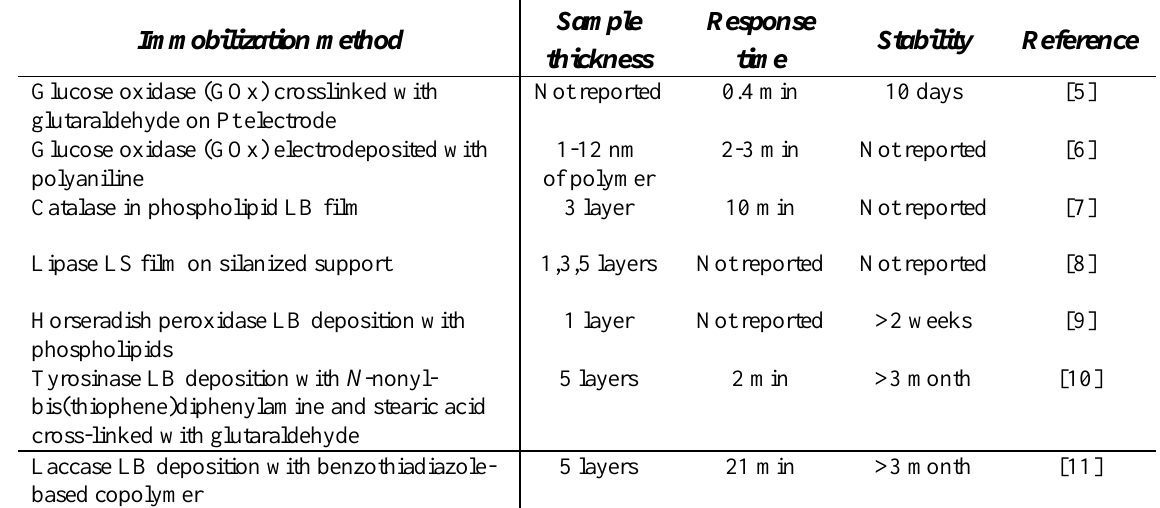
Table 1. Comparison of selected protein sensors immobilized in thin